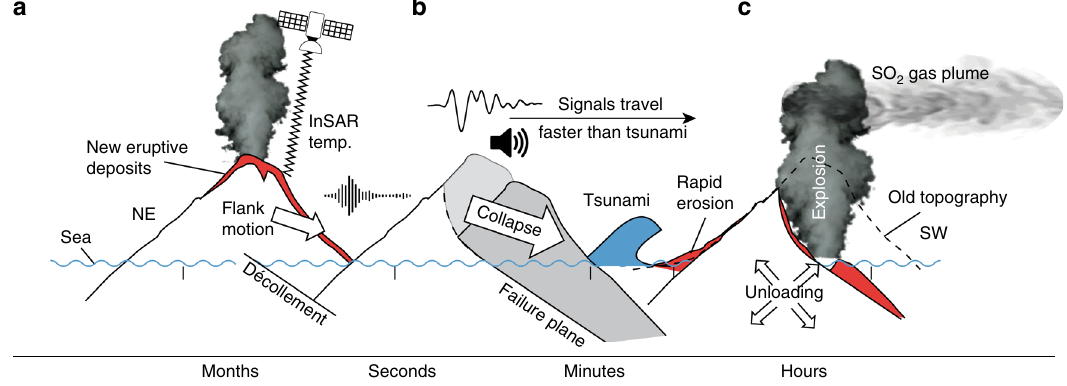
Fig. 6 Cascade of precursors leading up to the 22 December 2018 sector collapse event. a Precursors include fl ank motion (white arrow), eruptions (represented as eruption cloud), and increasing eruptive deposits (red shaded areas) as assessed by satellite data (thermal, InSAR). A décollement (black line beneath the island) dips SW, but faulting had not yet breached the surface. Approximately 2 mins before the collapse, a seismic event was recorded (shown by seismic trace symbol). b The landslide collapse along a failure plane (black curved line beneath island) showed a 1 – 2-min-long low-frequency signal (seismic waveform). Infrasound instruments (speaker symbol) measured the collapse before the tsunami waves arrived. The collapse decapitated the island (gray shaded area). The tsunami (blue wave) caused damage and loss along the coast. c Postcollapse volcanic explosions occurred coincident with increased degassing (gray plume) caused by unloading (arrow symbol); the old topography is indicated (black dashed line). New eruptive deposits increased the island area (red shaded areas). Finally, rapid erosion deeply carved incisions into the fresh eruption